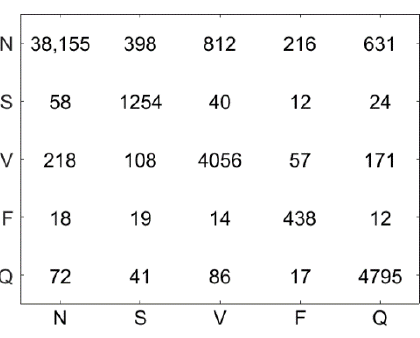
Figure 12. Confusion matrix using the FDDL model.